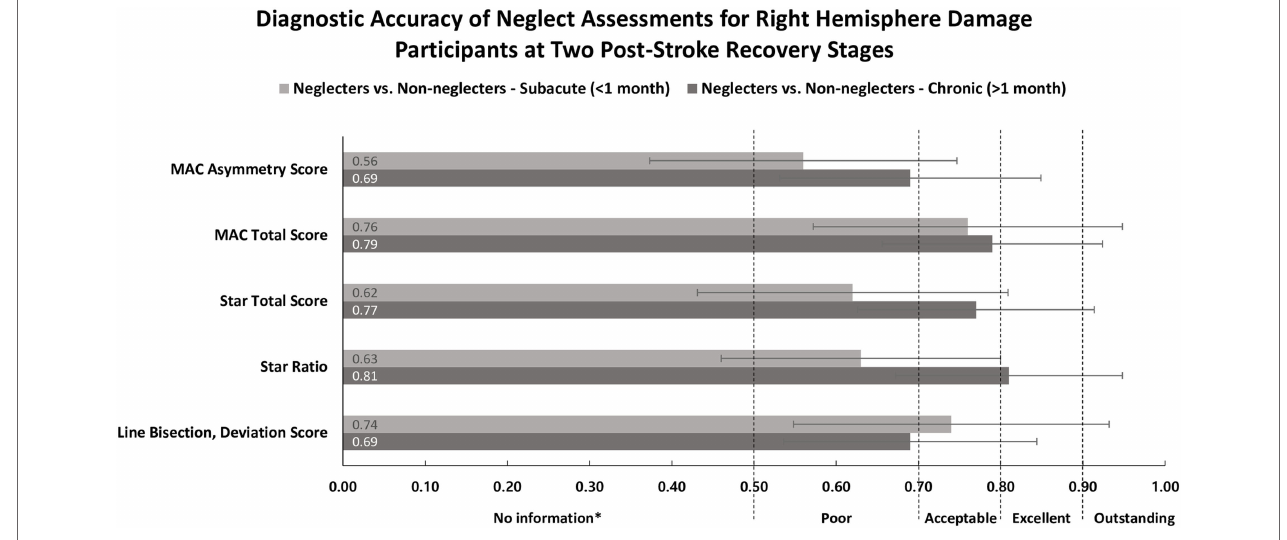
FigUre 2 | Area under the ROC curve ( x -axis) and neglect measures ( y -axis) for participants in subacute ( < 1 month) and chronic ( > 1 month) recovery stages. Classification terms (poor, acceptable, excellent, and outstanding) refer to the discriminative abilities of each outcome. Error bars represent 95% confidence intervals. Abbreviations: R, right; L, left; MAC, Mobility Assessment Course. *Test provides no useful